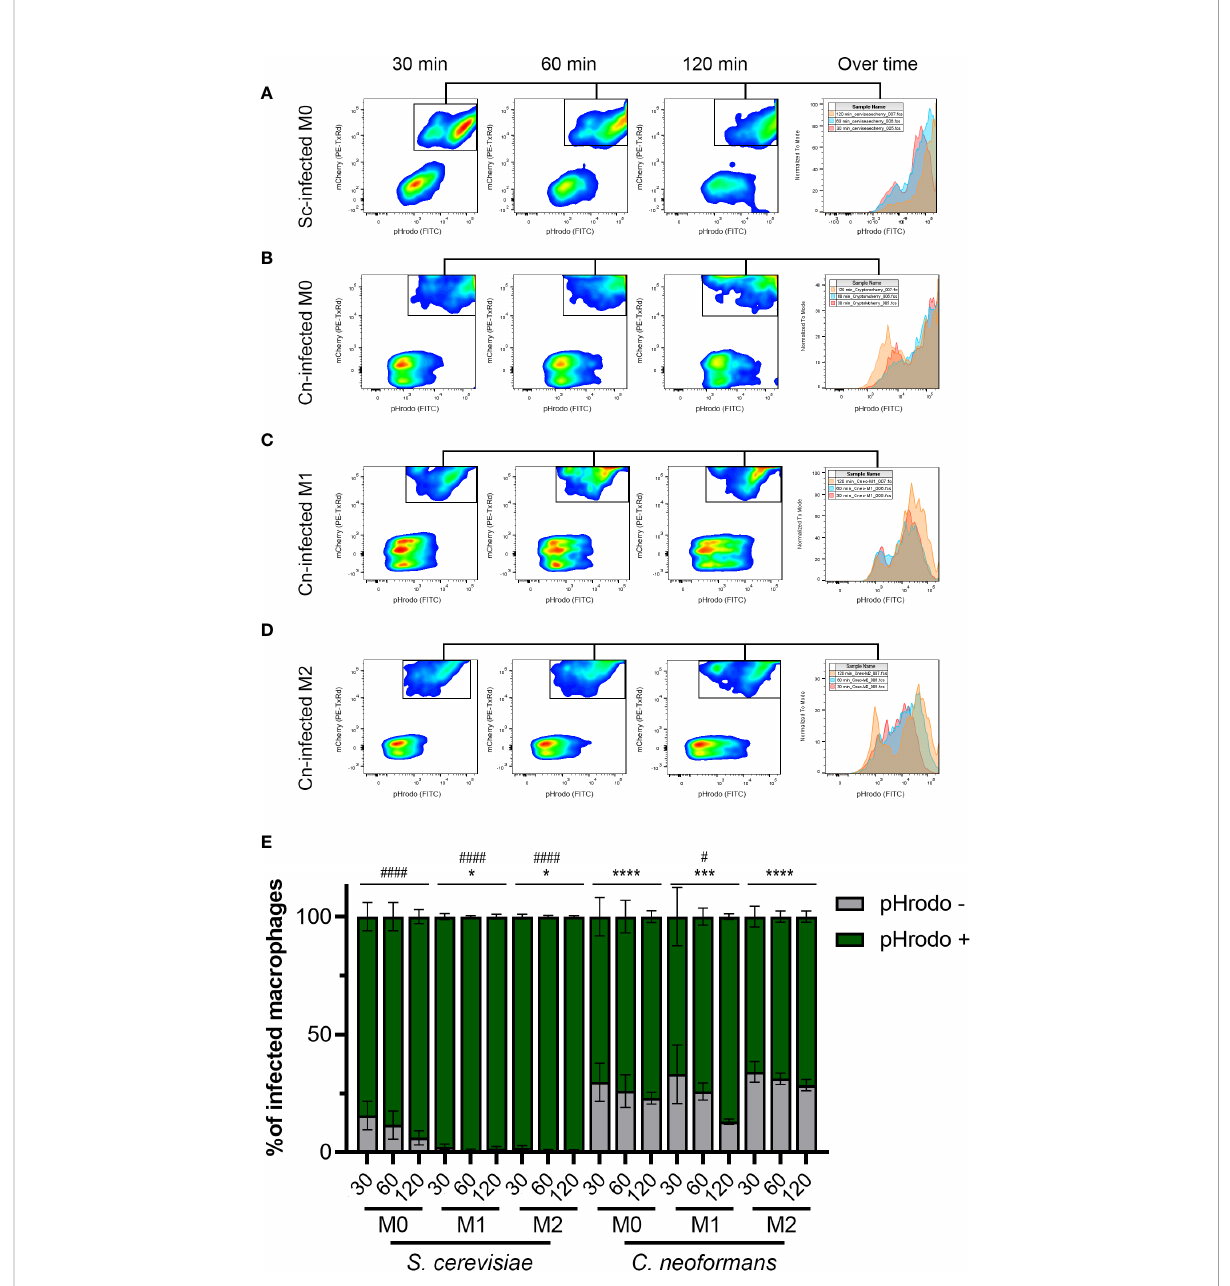
FIGURE 3 The majority of C neoformans phagosomes exhibit impaired acidi fi cation but this is modulated by the macrophage polarization state. (A) Representative fl ow plots of 30, 60, and 120-minute incubation of S. cerevisiae (Sc) with M0 macrophages. The histogram to the right shows the relative number of pHrodo-positive events over time. (B – D) Representative fl ow plots of 30, 60, and 120-minute incubation of C neoformans (Cn) with (B) M0, (C) M1, and (D) M2 macrophages. The histogram to the right shows the relative number of pHrodo-positive events over time. See Figure S3 for more details on the gating strategy. (E) Quanti fi cation of infected macrophages with the indicated fungal species at 30, 60, and 120 minutes by fl ow cytometry. Shown is the average and error of the mean for 2 - 4 independent experiments. Statistics are a 2-way ANOVA with multiple comparisons. The asterisks (*) represent comparisons to S. cerevisiae -infected M0 cells. The number sign (#) represent comparisons to C neoformans -infected M0 cells. * or #, P < 0.05; ***, P < 0.001; **** or ####, P <